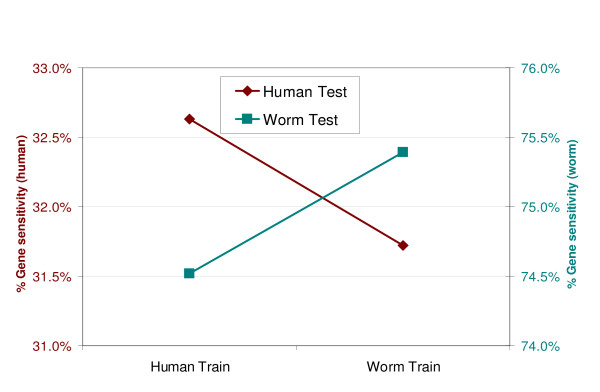
Trainability of ESTseq parameters. The human and worm genes were each divided into two halves, one for training and one for testing. ESTseq parameters were estimated separately from half the human genes and half the worm genes. Each set of parameters was then tested separately on the other half of the human genes and the other half of the worm genes. The same models were used for both human and worm ESTseqs (5th-order Markov Models for the coding regions, UTRs, Introns and intergenic regions, 43-base-long 2nd-order WAM for splice acceptor sites and 9-base-long 2nd-order WAM for the splice donor sites).